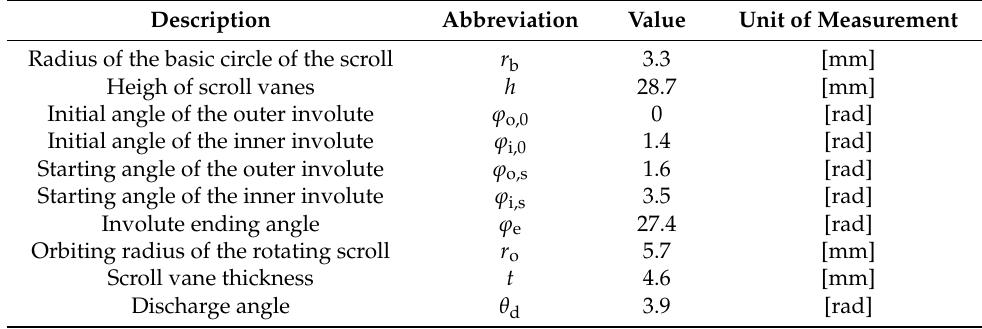
Table 1. Geometrical parameters of the scroll expander [35]. Description Abbreviation Value Unit of Measurement Radius of the basic circle of the scroll r b 3.3 [mm] Heigh of scroll vanes h 28.7 [mm] Initial angle of the outer involute ϕ o,0 0 [rad] Initial angle of the inner involute ϕ i,0 1.4 [rad] Starting angle of the outer involute ϕ o,s 1.6 [rad] Starting angle of the inner involute ϕ i,s 3.5 [rad] Involute ending angle ϕ e 27.4 [rad] Orbiting radius of the rotating scroll r o 5.7 [mm] Scroll vane thickness t 4.6 [mm] Discharge angle θ d 3.9